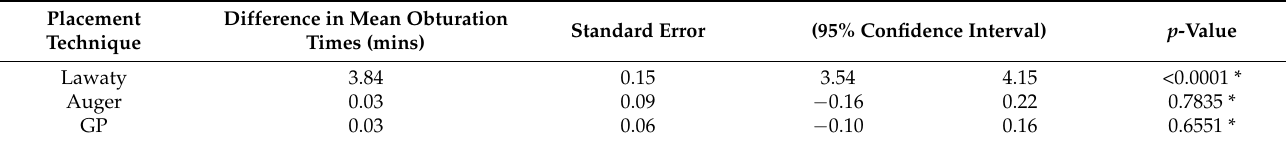
Table 3. Results of estimated differences in mean obturation times (95% confidence intervals) with the plugger group set as the reference group.